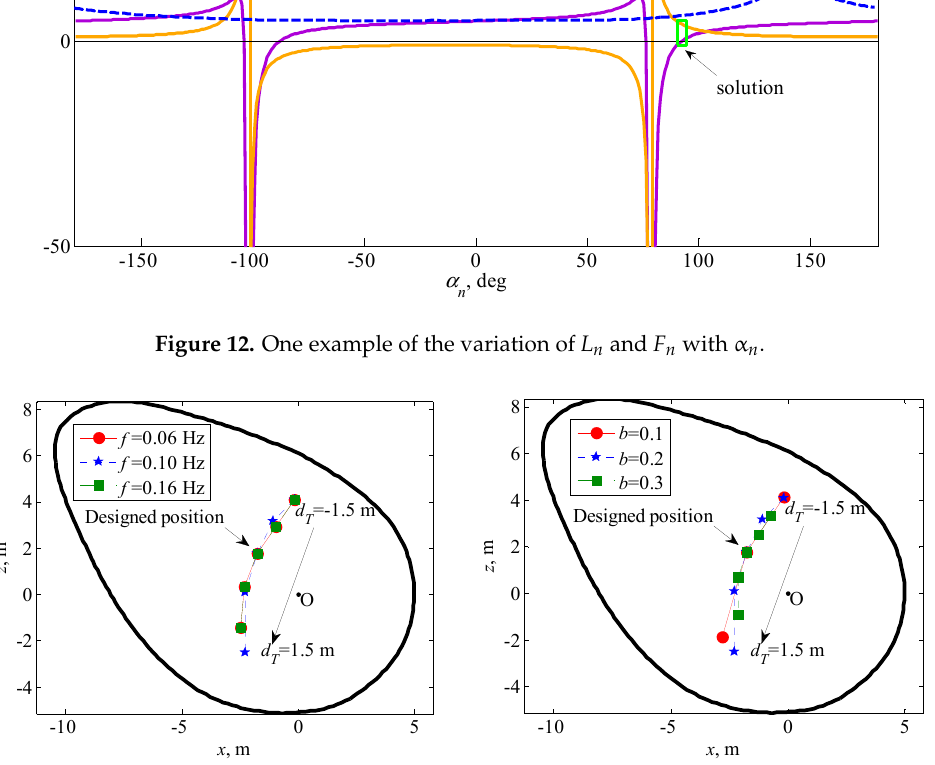
Figure 12. One example of the variation of L n and F n with α n .